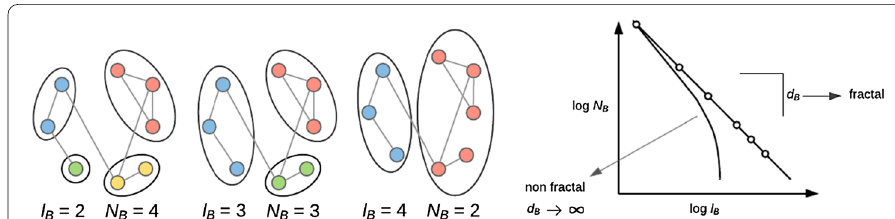
Fig. 1 On the left: the illustration of the box-covering problem on a small graph. On the right: a schematic plot depicting the scaling of the number of boxes for a fractal and a non-fractal network. The figure was motivated by Gallos et al.